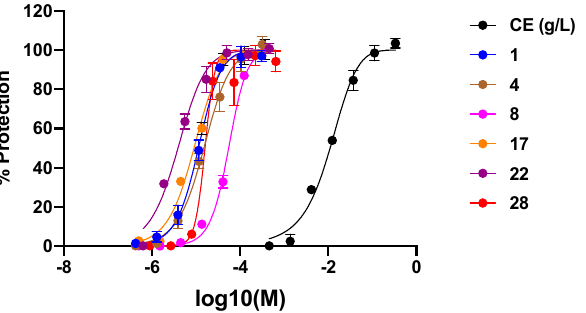
Figure 3. Protective effects of the crude extract (CE) along with compounds 1 , 4 , 8 , 17 , 22 , and 28 of Cassia abbreviata against HIV-1 infection ( n = 3).